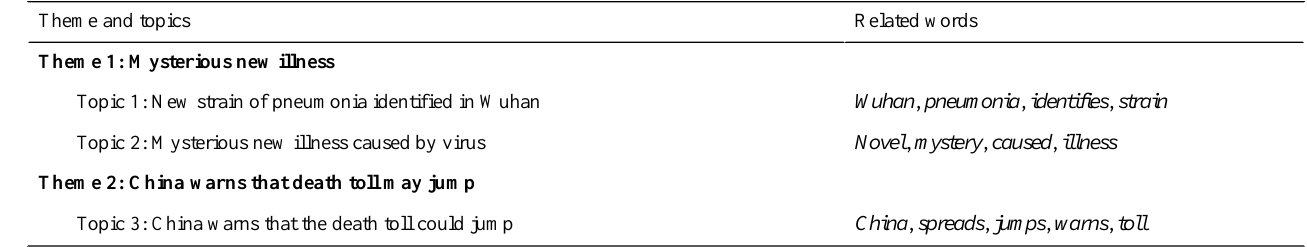
Table 2. The emergent topics and themes related to the outbreak of COVID-19.